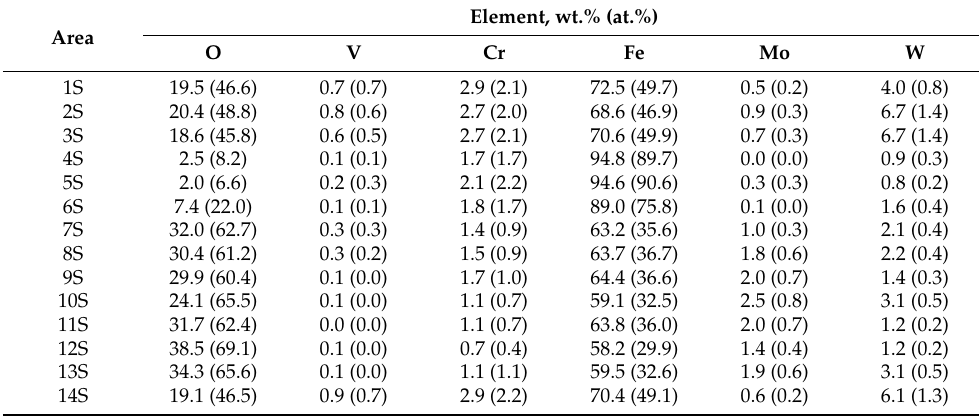
Table 6. EDS chemical composition of the AISI 52,100 counterbody worn surface on sliding at 3.6 m/s (Figure